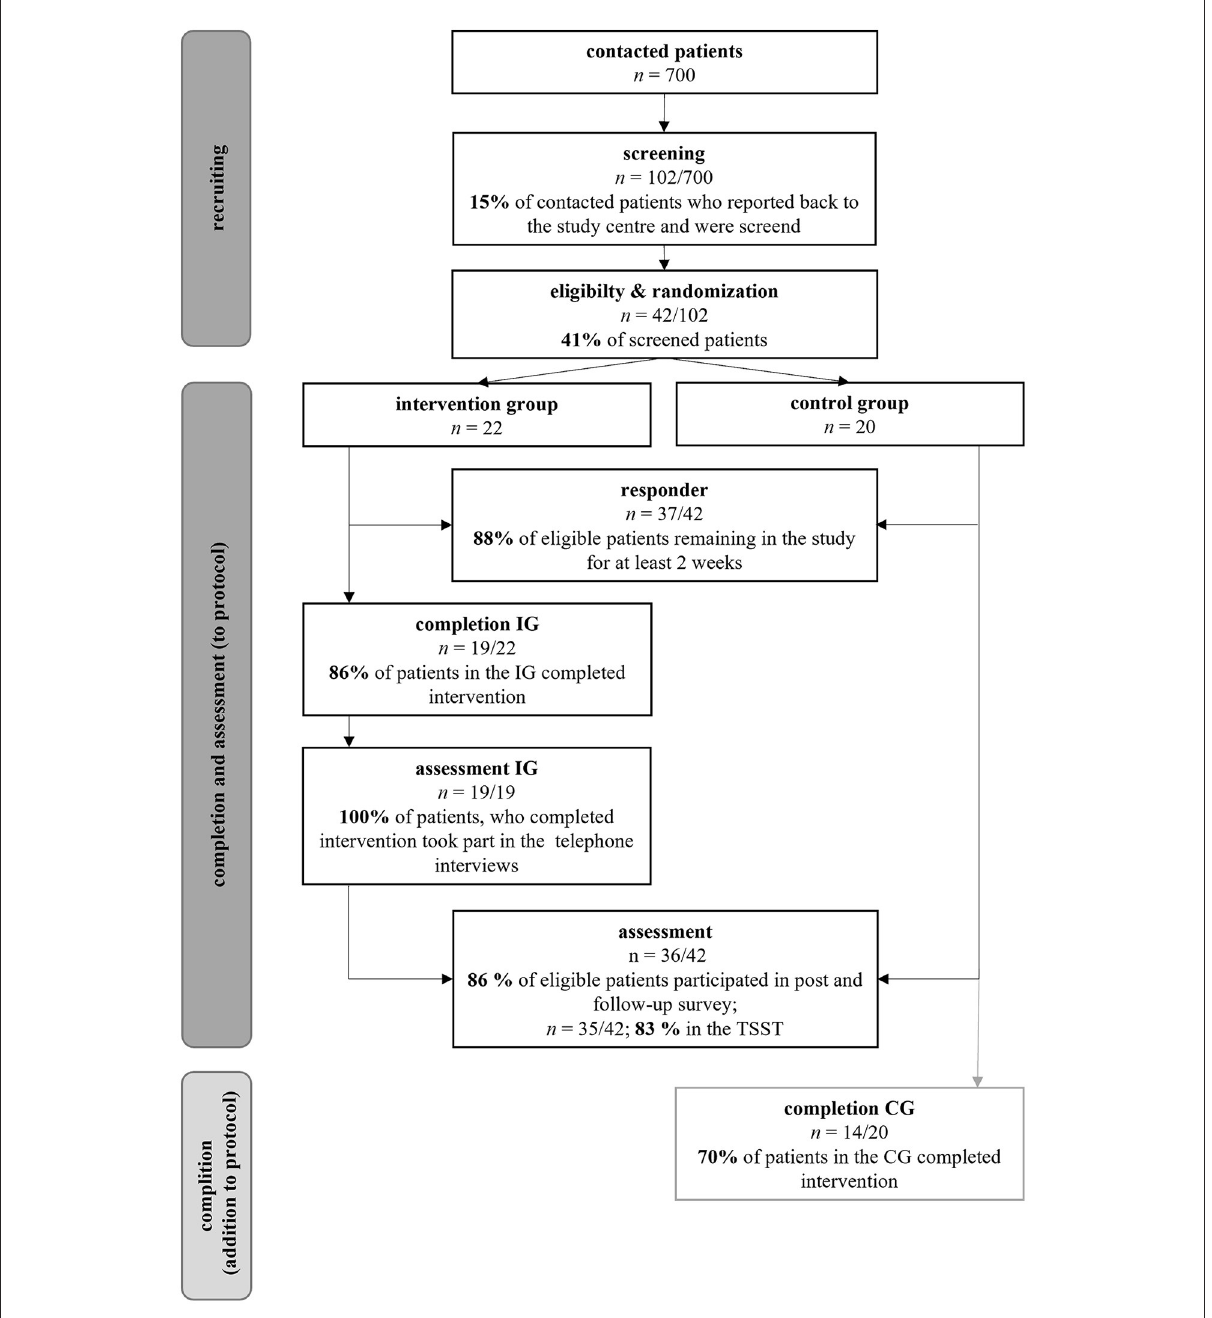
FIGURE2 Recruitment success, compliance and feasibility of the intervention. Reasons for non-response and drop-out see Figure